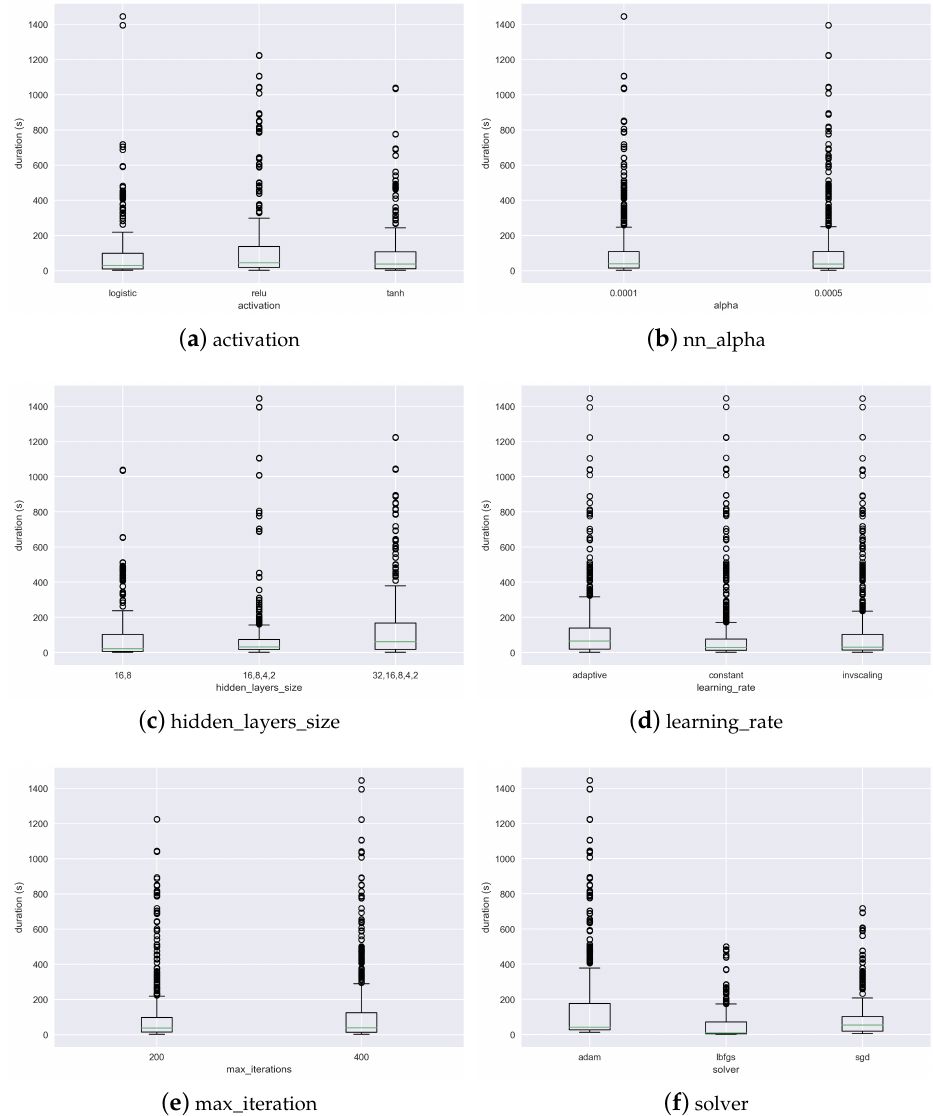
Figure 8. Distribution of the training time for each of the different values set in each of the six hyperparameters tested in the Neural Network algorithm: activation, nn_alpha, hidden_layers_size, learning_rate, max_iteration and